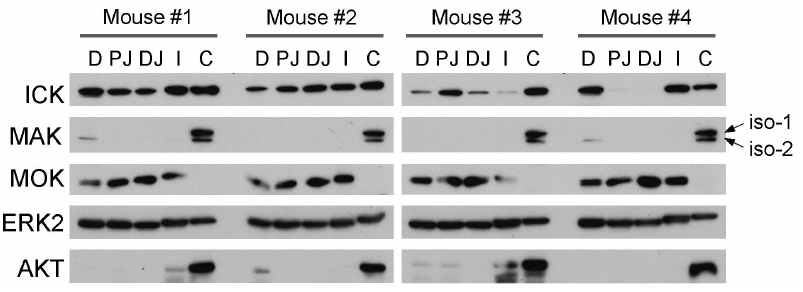
Figure 3. Expression of ICK/MAK/MOK proteins along the duodenum-to-colon axis in the intestine. The intestinal tube was rapidly dissected from four littermates of postnatal day 21 and segmented into duodenum (D), proximal jejunum (PJ), distal jejunum (PJ), ileum (I), and colon (C) respectively. Tissue extracts were prepared from frozen intestinal tissues. Equal amount of total proteins (50 m g) were loaded on Western blot against ICK, MAK, and MOK antibodies respectively. ERK signal was shown to demonstrate an equal distribution pattern along the duodenum-to- colon axis, whereas AKT signal was shown to demonstrate a colon-enriched distribution pattern under the normal steady-state condition.